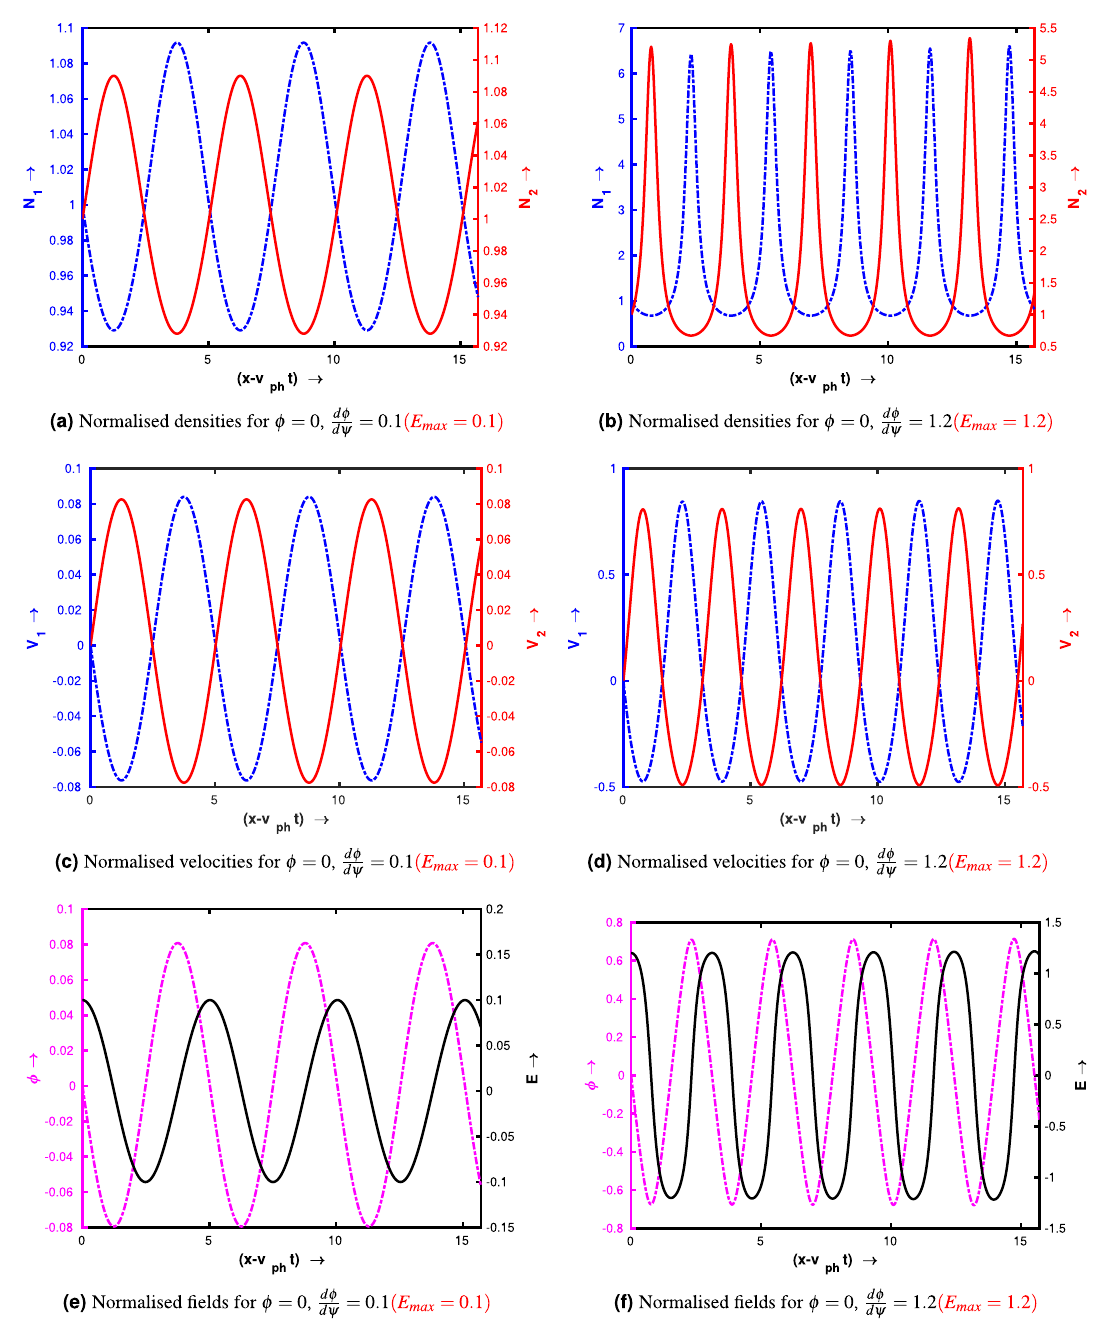
Figure 3. Profile of the wave for δ i = 0.9 , γ ph = 100 , β th , e = 0.3 , Q = 1 , µ = 1 and κ = 20